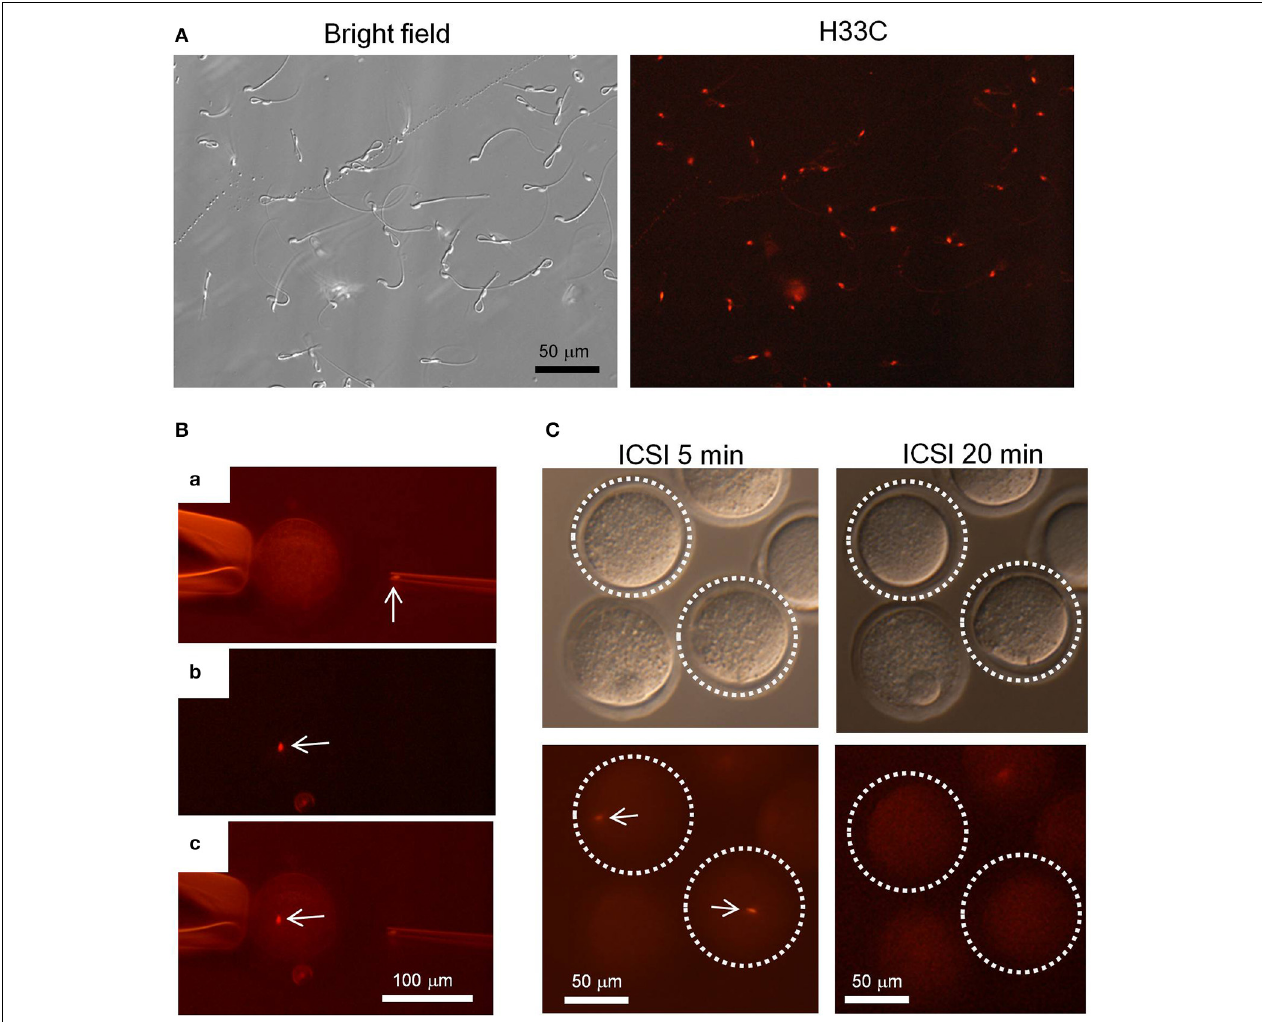
FIGURE 6 | Intra-cytoplasmic sperm injection (ICSI) using H33C sperm. (A) Expression of H33C in the head of epididymal sperm. (B) A representative image of performing ICSI using H33C sperm. (a) An H33C-positive sperm head in an injection capillary before injection. (b,c) An